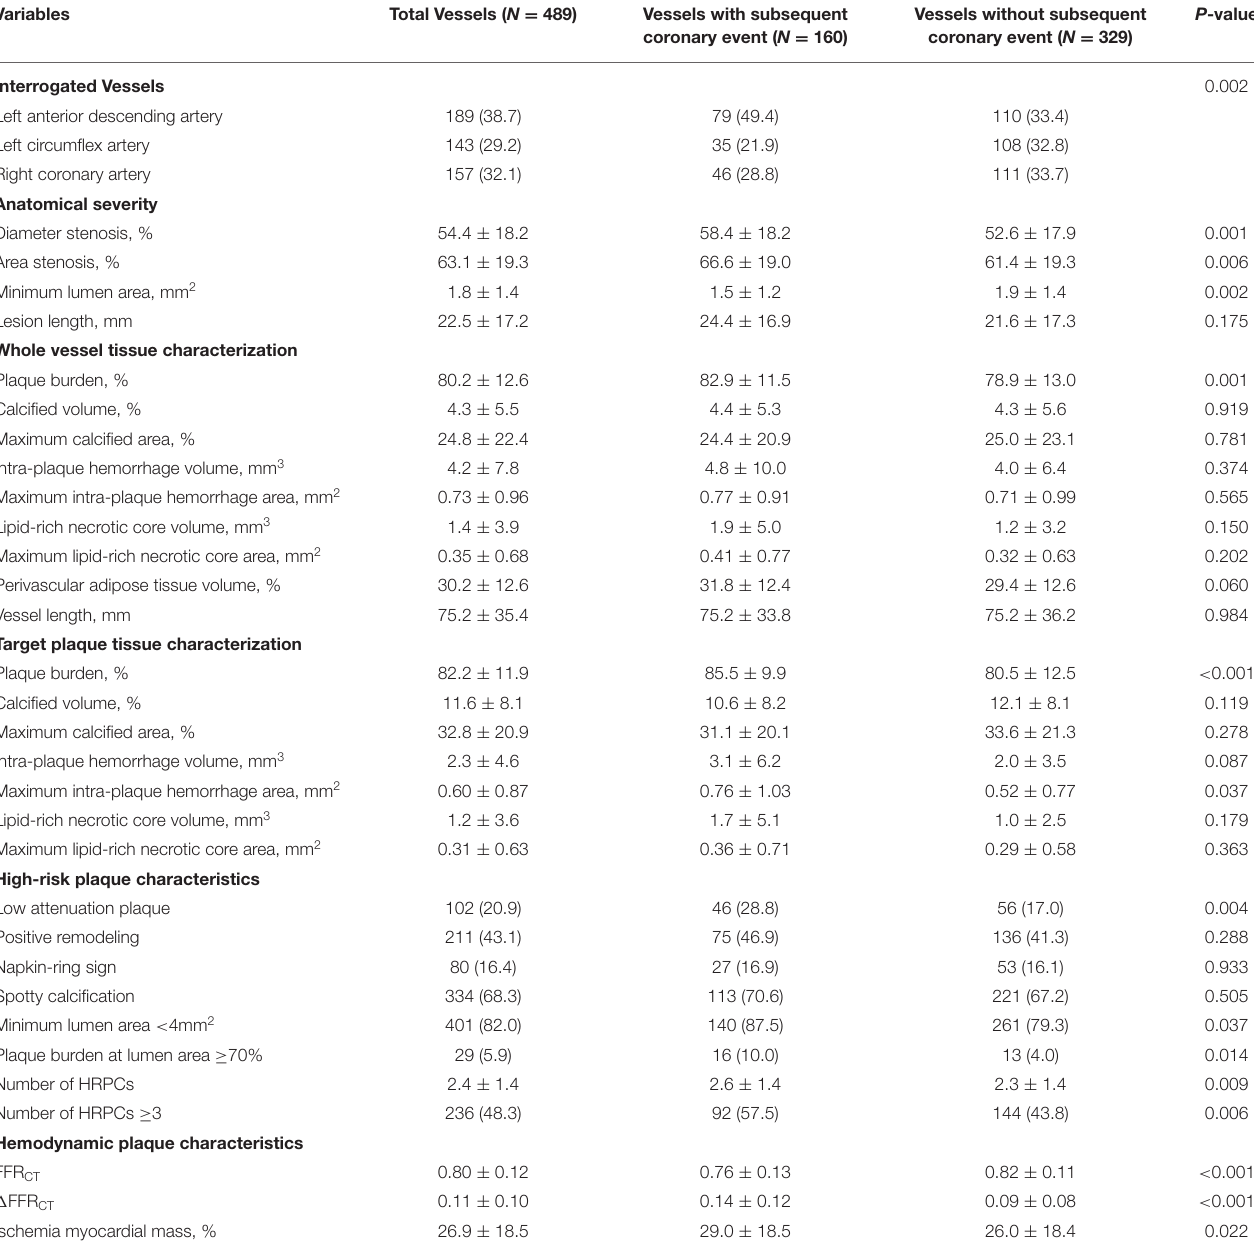
TABLE 2 | Anatomic and hemodynamic plaque